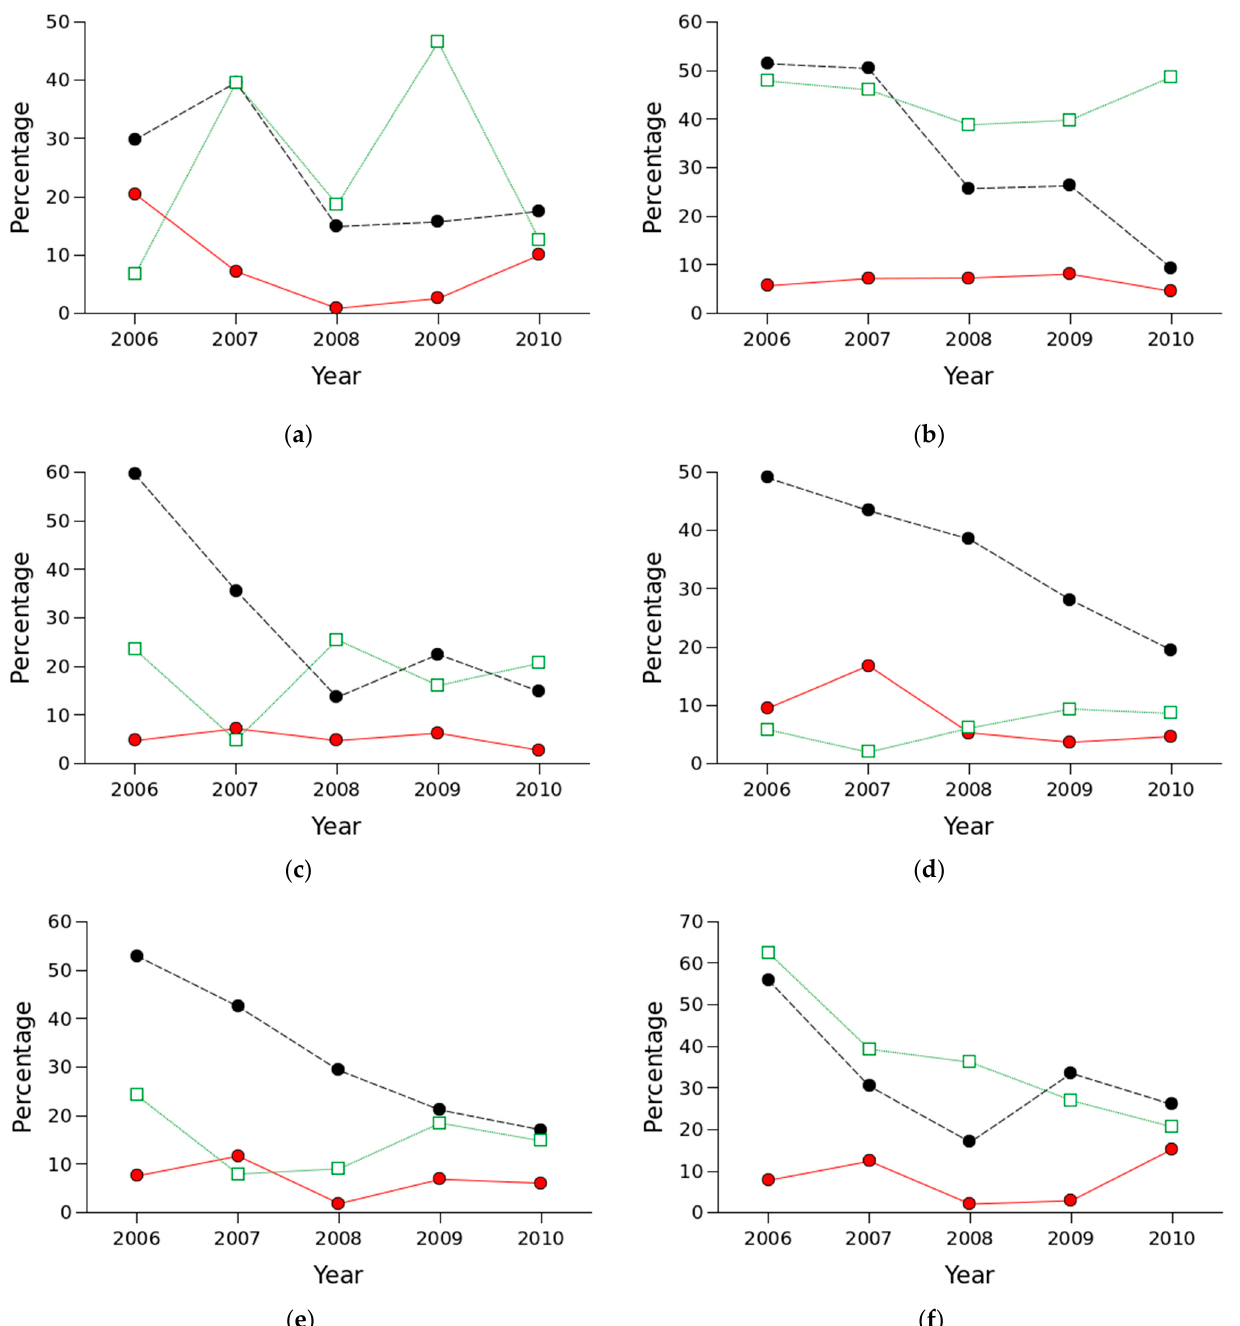
Figure 2. Total parasitism (full red line), total other mortality (dashed black line), and leaf damage inflicted by C. ohridella larvae (dotted green line, open squares) at six sites in the Czech Republic from 2006 to 2010. ( a ) Praha; ( b ) Plze ň ; ( c ) Liberec; ( d ) Č eské Bud ě jovice; ( e ) Brno; ( f ) Rožnov pod Radhošt ě m.